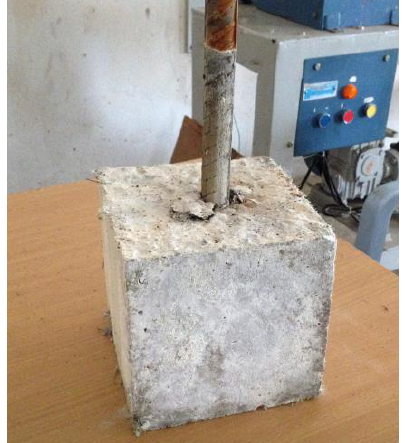
Figure 5. Test specimen after pull-out